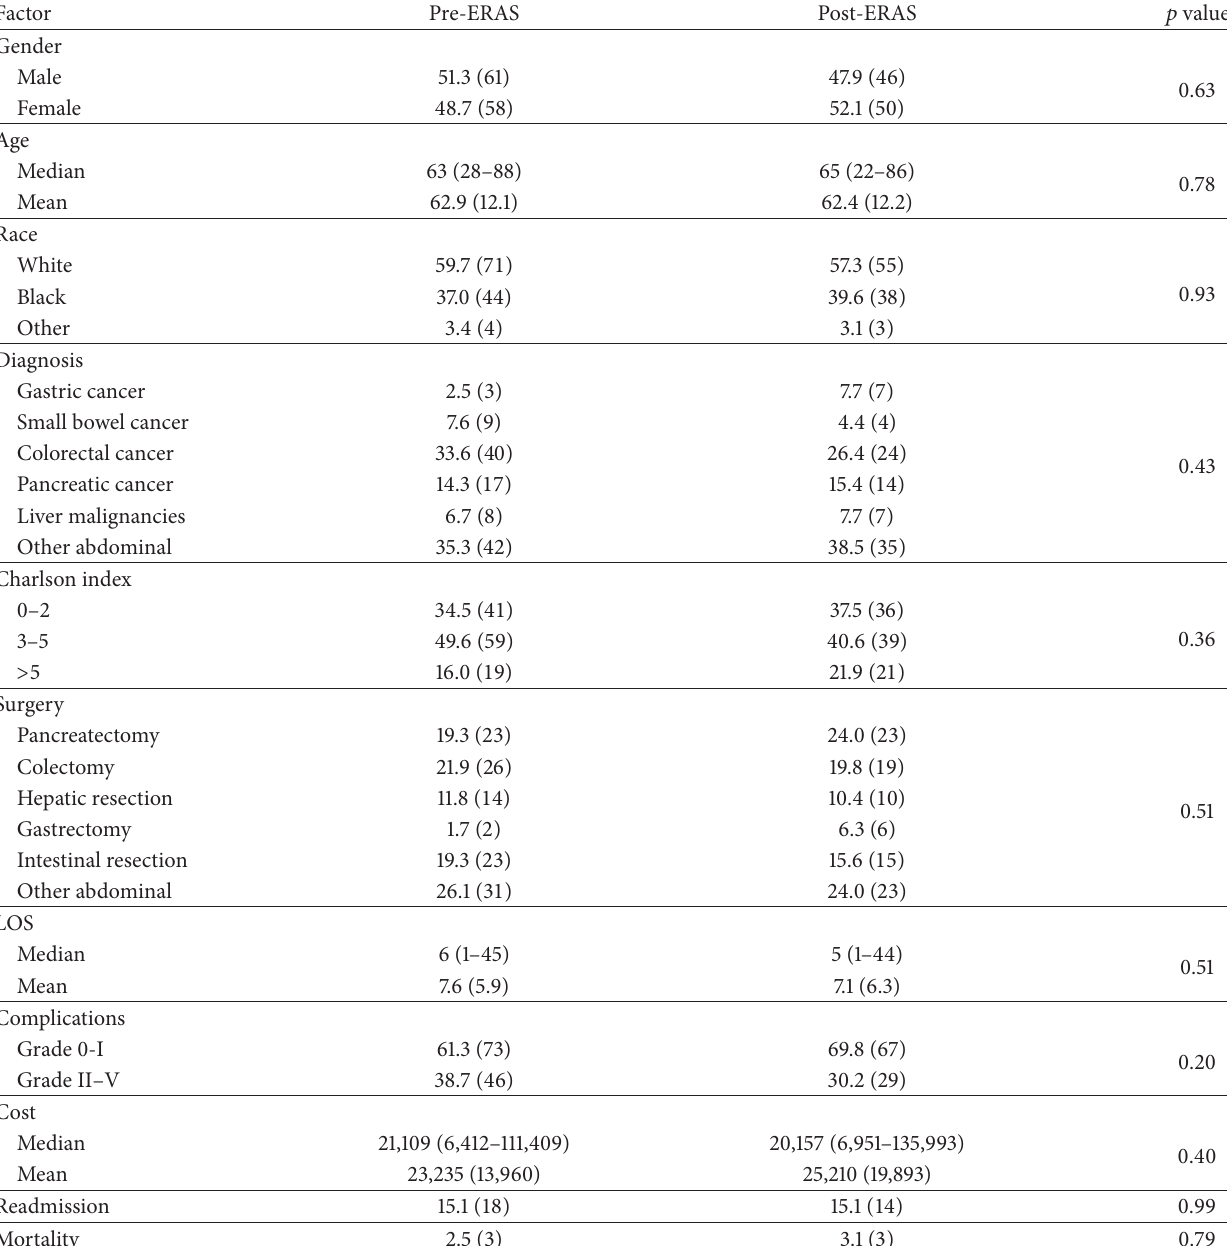
Table 5: Control providers before and after ERAS implementation,